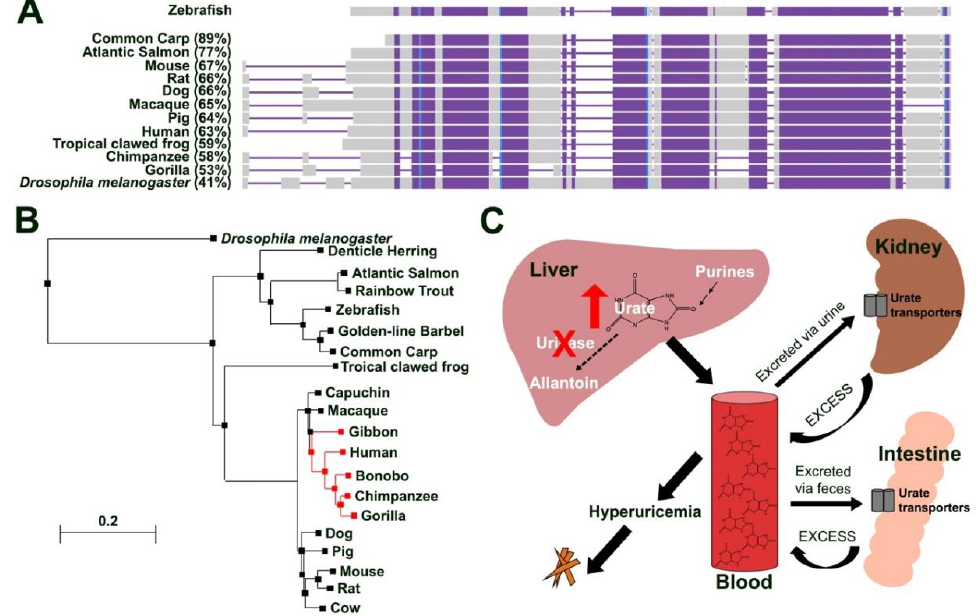
Figure 1. Zebrafish uricase is highly conserved. ( A ) Schematic illustrating amino acid conservation between zebrafish Uox with urate oxidases from other fish species (common carp ( Cyprinus carpio carpio ), Atlantic salmon ( Salmo salar )), rodents (mouse ( Mus musculus ) and rat ( Rattus norvegicus )), tropical clawed frog ( Xenopus tropicalis ), dog ( Canis lupus familiaris ), pig ( Sus scrofa ), primates (macaque ( Macaca mulatta ), gorilla ( Gorilla gorilla gorilla ), chimpanzee ( Pan troglodytes ), human ( Homo sapiens )) and Drosophila melanogaster (percentages show amino acid conservation with zebrafish Uox). Alignment columns with no gaps are coloured in blue and violet. Violet colour indicates highly conserved regions (same residue in all alignment rows) and blue indicates less conserved regions. Unaligned residues are shown in grey. ( B ) Phylogenetic analysis of zebrafish Uox using BLASTP and the neighbour joining method with a Grishin distance model. Species lacking a functional uricase protein are highlighted in red. ( C ) Schematic illustrating urate metabolism in humans (that lack a functional urate oxidase (uricase) protein) and the contribution of hyperuricemia to MSU crystal formation. Purines are catabolized in the liver to urate, which is further degraded into allantoin in the presence of a functional uricase protein. Higher primates (including humans) lack a functional uricase making them sensitive to developing hyperuricemia, a risk factor for MSU crystal deposition and gout. Due to its water-insoluble properties, excess urate from the excretory pathway (kidney and intestines) is released back into the blood